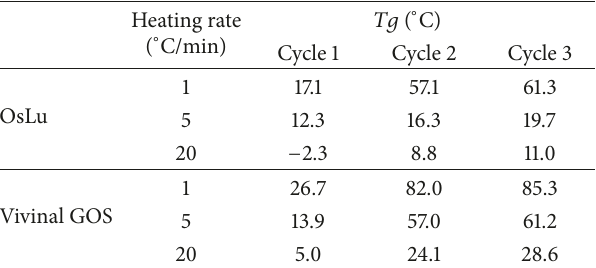
Table 2: 𝑇𝑔 values obtained after the analysis of OsLu and Vivinal GOS by DSC using three heating rates and three subsequent cycles of heating and